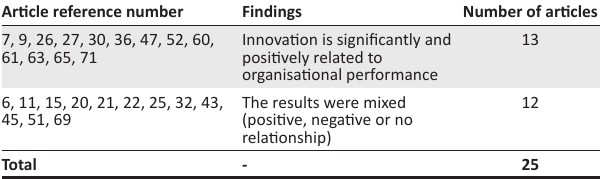
TABLE 5: Objective measures of organisational